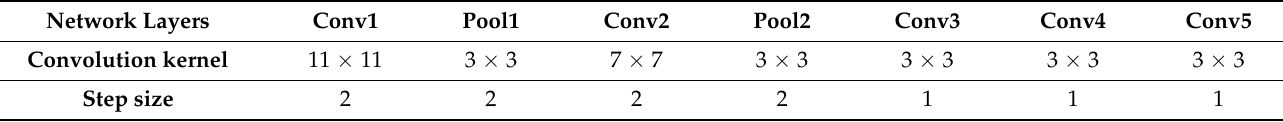
Table 1. Network